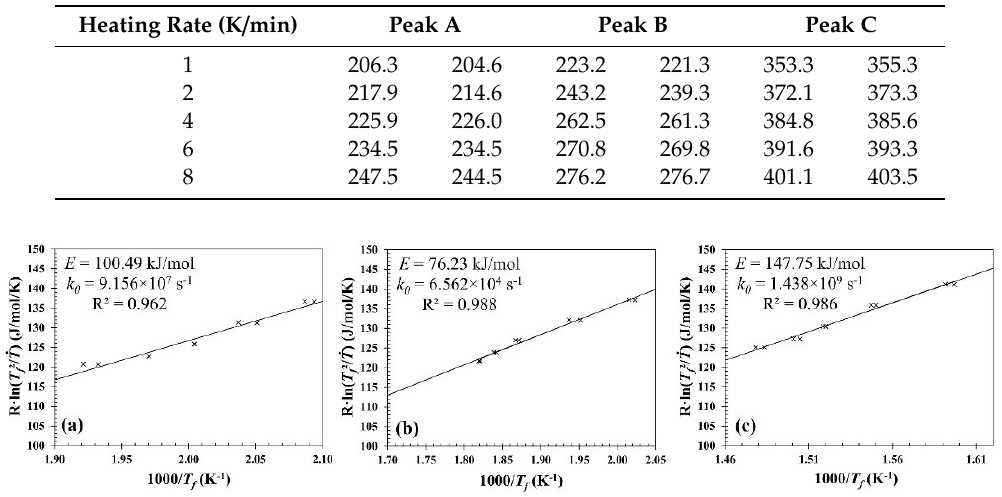
Table 2. DSC peak temperatures T f = T Peak obtained at different heating rates for the AlSi7Cu3.5Mg0.15 (Mn, Zr, V) alloy.